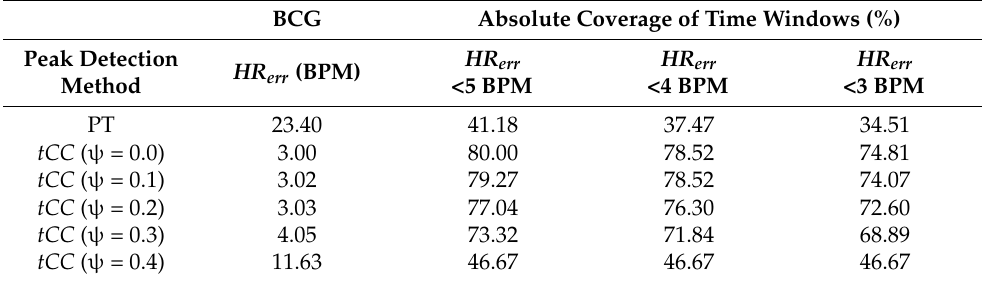
Table 3. BCG HR err and absolute coverage of various HR err criteria for 6 s windows measured depending on each peak detection method in resting states after arm